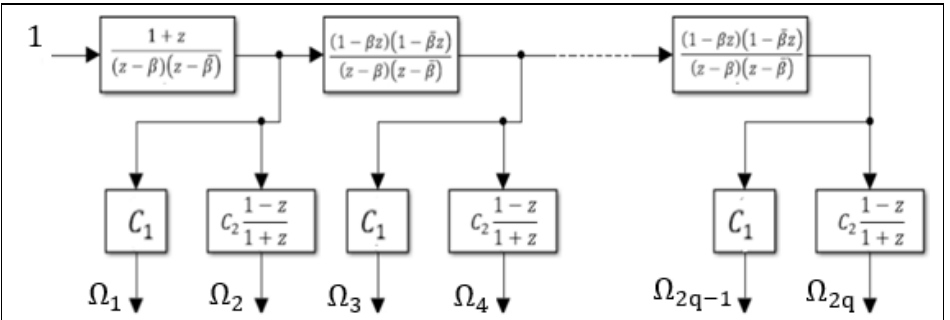
Figure 1. Illustration of Kautz